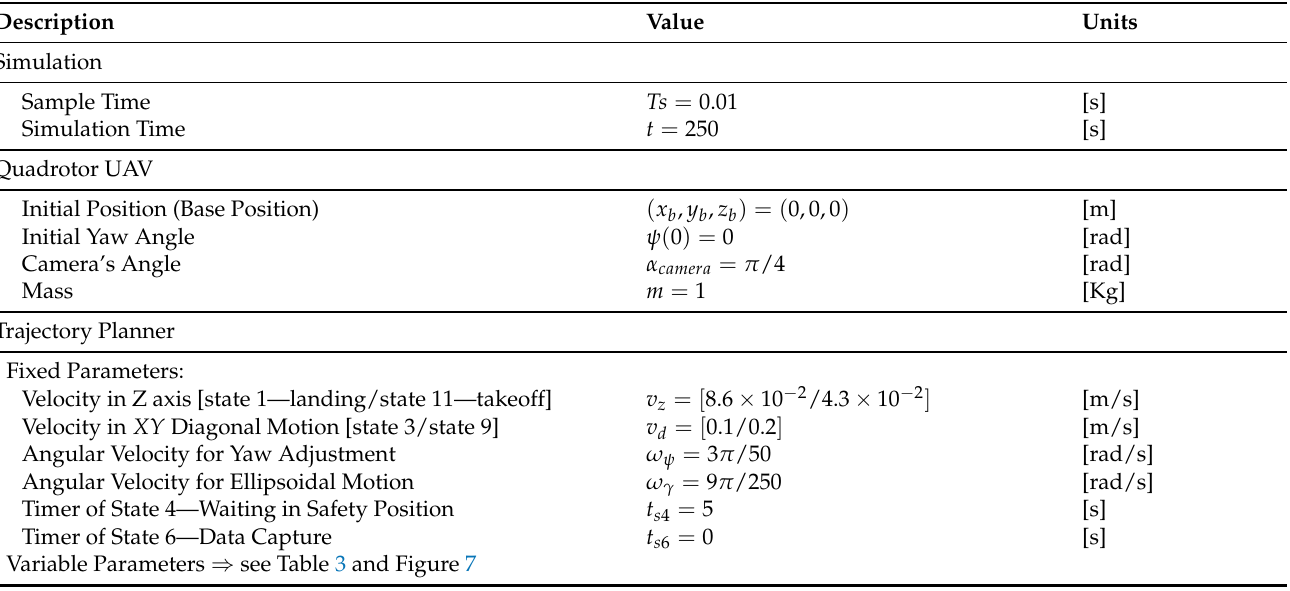
Table 4. Parameters defined in the UAV simulator (MATLAB/Simulink ®